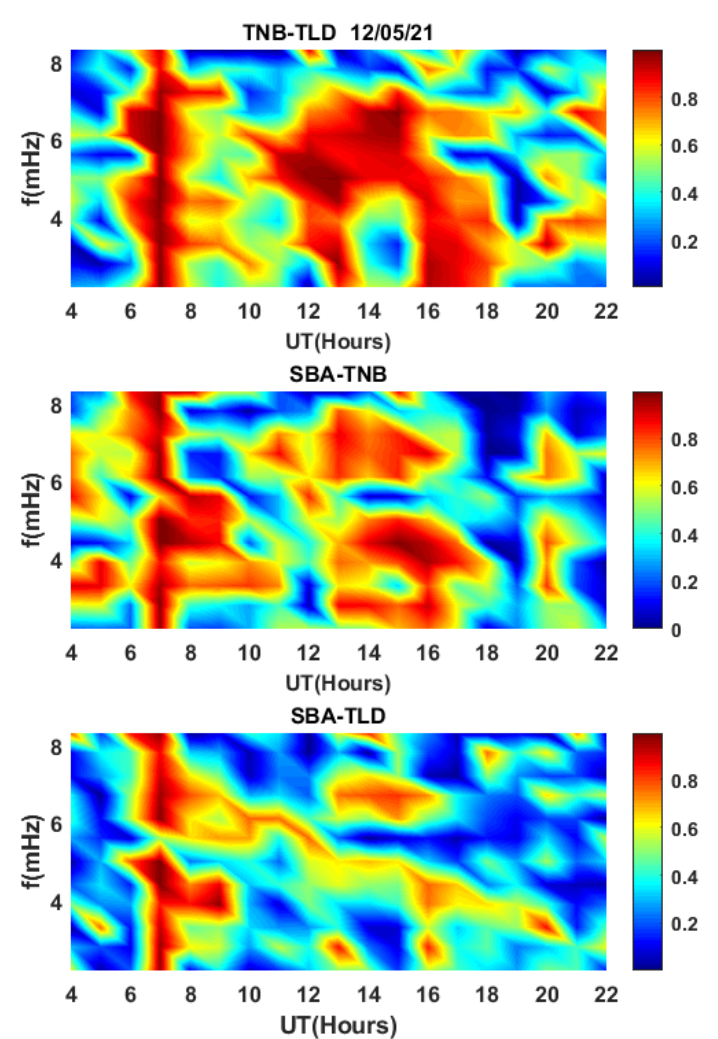
Figure 8. Dynamic coherence of the H component for the three possible coupled stations for the disturbed day.